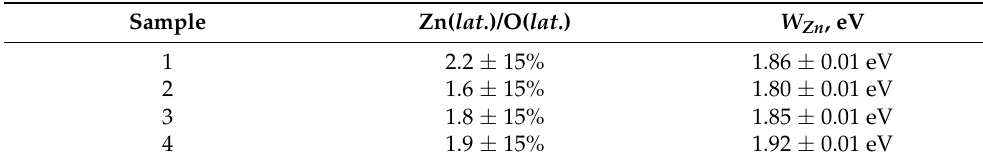
Table 2. Values of Zn( lat .)/O( lat .) and Zn 2p3/2 line width at half height ( W Zn ).